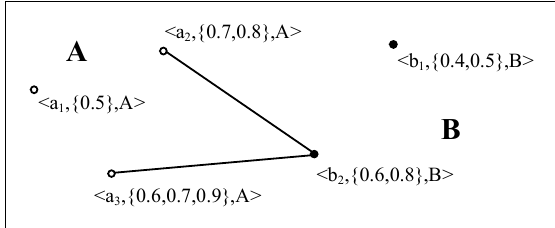
Figure 1. The spatial object features and the instances